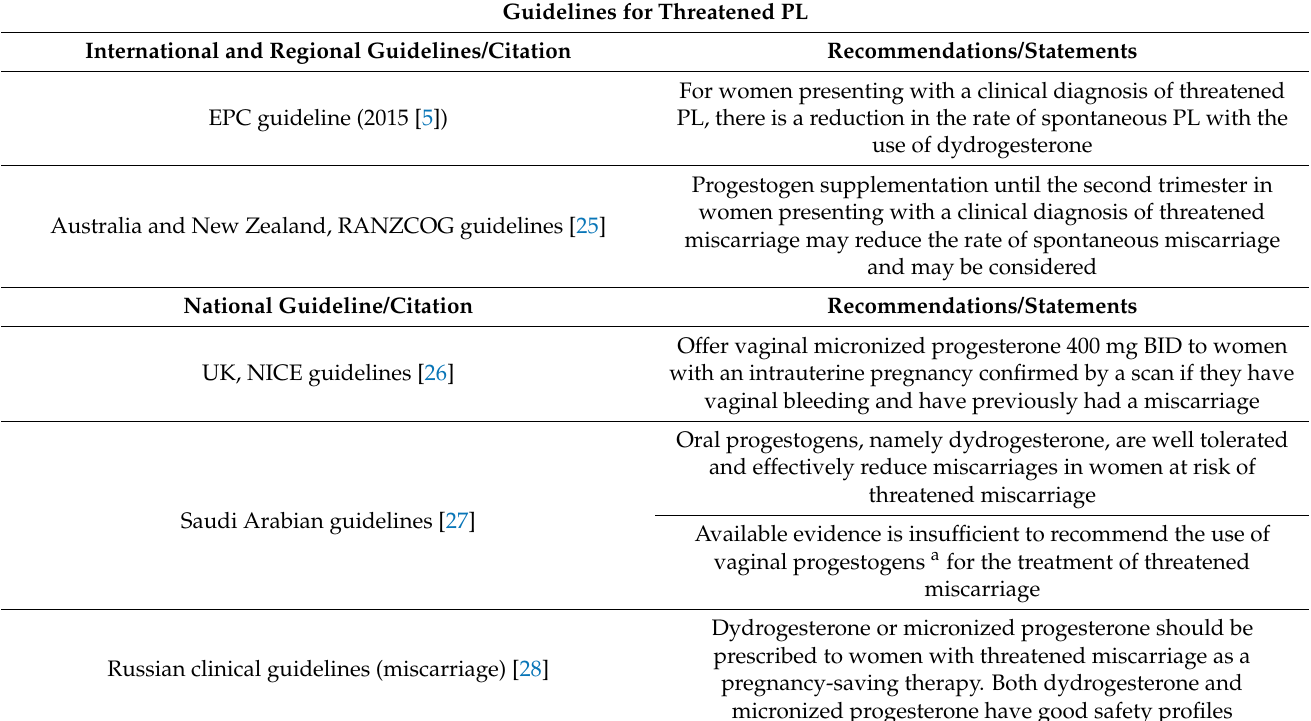
Table 1. Summary of guidelines for treatment of pregnancy